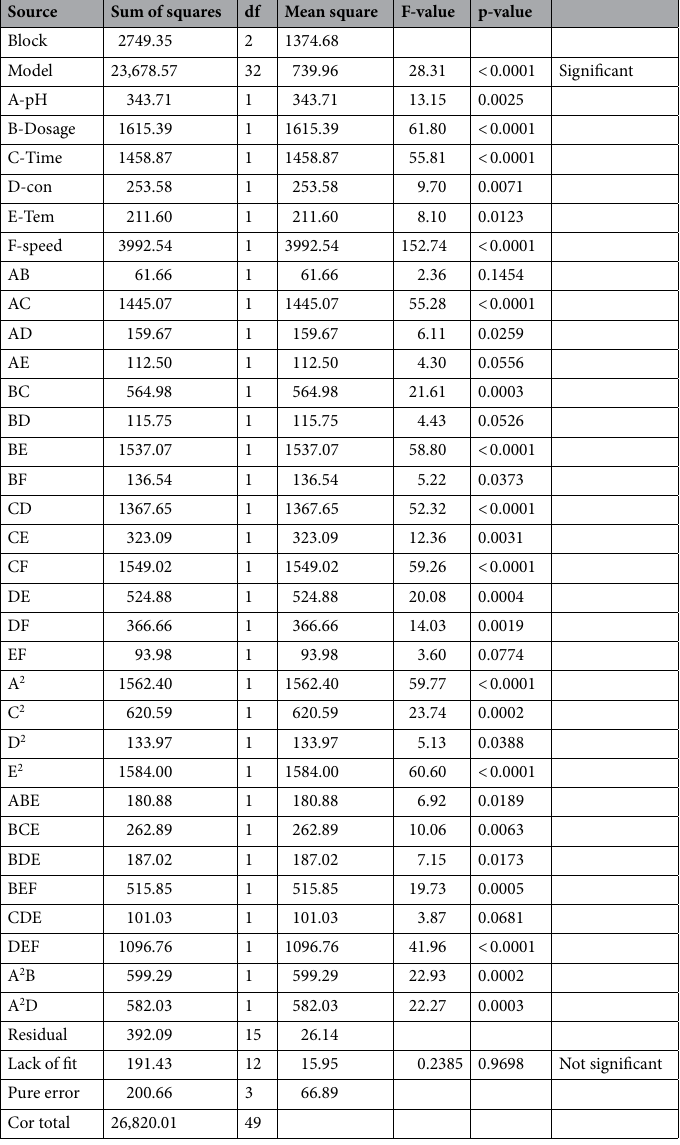
Table 2. Analysis of variance (ANOVA) for MB removal with Fe 3 O 4 @MOF-PAMAM imbedded in CA